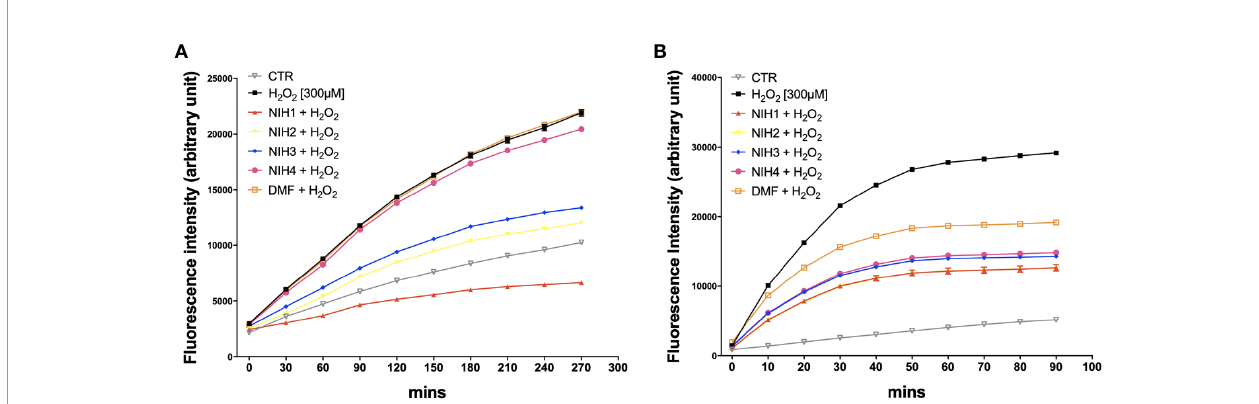
FIGURE 5 | NIH are endowed of anti-oxidant properties. (A) ARPE-19 cells were exposed to H 2 O 2 [300 m M] ± NIH1, NIH2, NIH3 and NIH4 [5 m M], or DMF [10 m M] for 4.5 h. Control cells were exposed only to solvent (DMSO). ROS levels were measured every 30 min by the fl uorometric 2 ′ ,7 ′ -Dichloro fl uorescin diacetate (DCF- DA) assay. Results are expressed as mean ± SEM. Fluorescence intensity for the NIH1, NIH2, NIH3, is signi fi cantly different from H 2 O 2 at any time starting from 30 min with p <0.001. Dunnett ’ s multiple comparisons test versus H 2 O 2 ; n = 4. (B) ARPE-19 cells were pre-treated for 24 h with either solvent (DMSO, CTR), NIH1, NIH2, NIH3, NIH4 [5 m M], or DMF [10 m M], and then exposed to H 2 O 2 [300 m M] for 1.5 h. ROS levels were measured every 10 min by the DCF-DA assay. Results are expressed as mean ± SEM. Fluorescence intensity for all the NIH and DMF is signi fi cant at any time starting from 10 min with p <0.0001. Dunnett ’ s multiple comparisons test versus H 2 O 2 ; n =